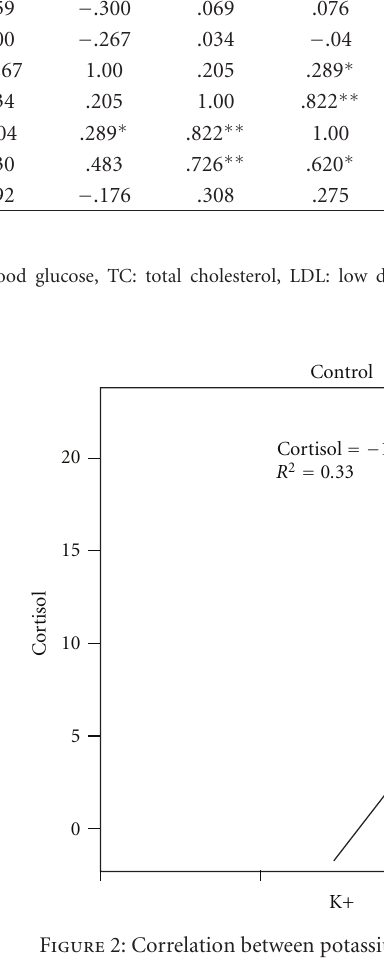
and known environmental factors (increased dietary fat consumption, and so forth) leading to eventual